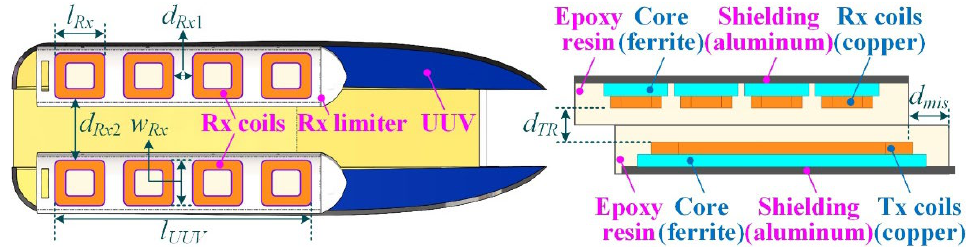
Figure 7. Size marks and material description of multi-Rx coil structure on USV. Table 1. Geometry parameters of Tx and Rx coils of different coil structures.